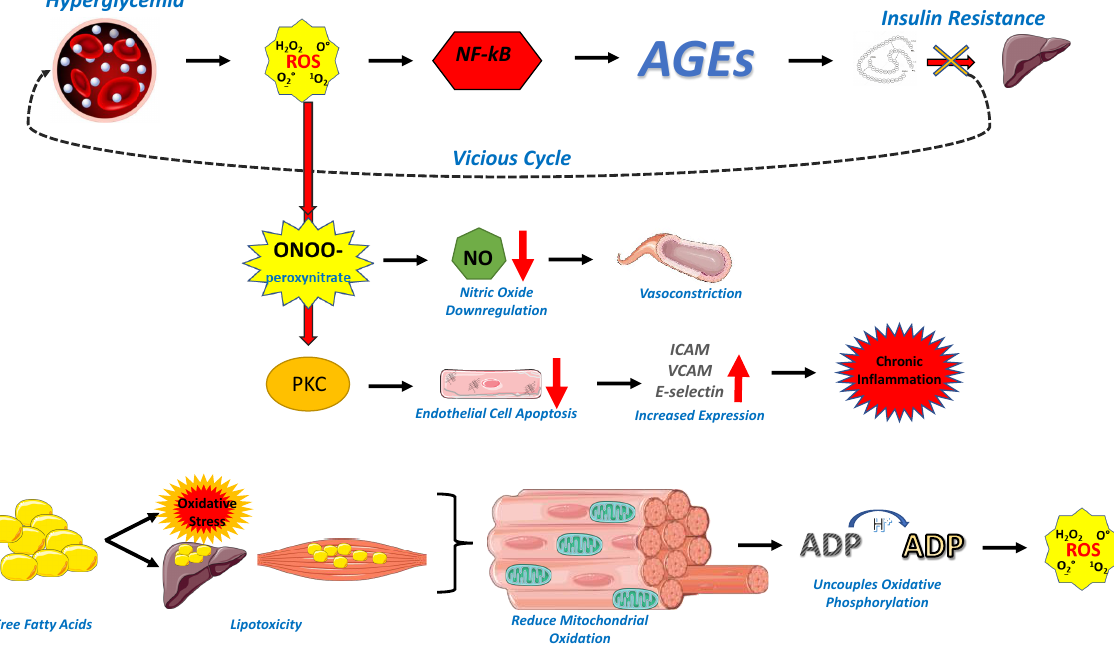
Figure 1. Cellular and biochemical mechanisms causing endothelial damage in patients with car- diometabolic disease. ROS; reactive oxygen species, NF-kB; nuclear factor kappa B, AGEs; advanced glycation end products, NO; nitric oxide, PKC; protein kinase c, ICAM; intracellular adhesion molecule, VCAM; vascular cell adhesion molecule, ADP; Adenosine